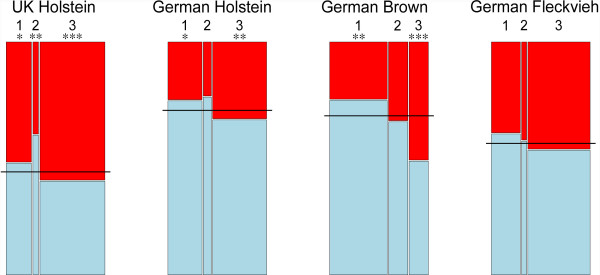
Haplotype Frequencies. Haplotype frequencies in UK Holstein, German Holstein, German Brown and German Fleckvieh BSE affected (red) and control (light blue) animals. Numbers above the columns represent the haplotypes: (1) 23ins-12ins, (2) 23del-12ins and (3) 23del-12del. The horizontal black lines indicate the expected proportions of cases and controls in each class. The thickness of the columns is proportional to the haplotype frequency. Stars indicate the level of significance: * < 0.05, ** < 0.01, *** < 0.001.